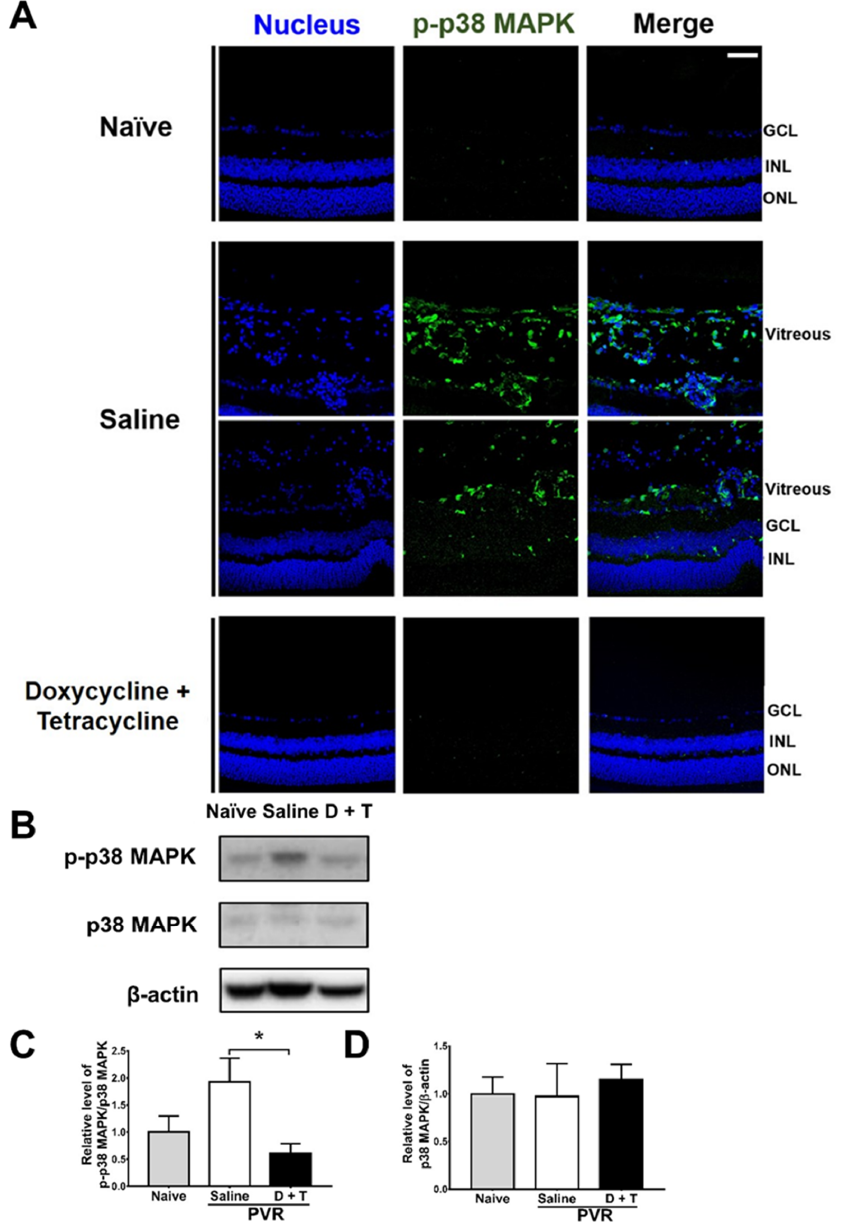
Figure 5. Doxycycline and tetracycline treatment decreases p38 MAPK phosphorylation in the retinas and vitreous of mice after PVR induction. ( A ) The eye sections of naïve mice or mice with PVR induction and treated with saline or doxycycline and tetracycline (D + T) were subjected to immunofluorescence staining with DAPI for the nucleus (blue) and the antibody against p-p38 MAPK (green) 21 days after induction. GCL: ganglion cell layer; INL: inner nuclear layer; ONL: outer nuclear layer. Scale bar, 50 μm. Data are the representative of at least 2 experiments. The retinas harvested from mice as described in ( A ) were subjected to Western blotting for p38 MAPK, p-p38 MAPK, and β-actin. The representative blots ( B ) and quantitated results ( C , D ) are shown. In each sample, the value of p-p38 MAPK was divided by that of p38 MAPK. The values of naïve mice were set as 1. The data represent means + SEM (error bars) of ≥3 samples per group. Note: *, p < 0.05 via Student’s t test.